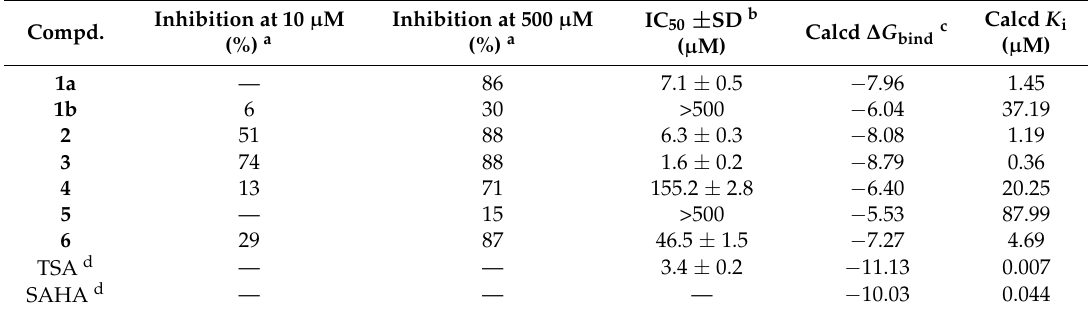
Table 1. HDAC inhibitory activity of compounds 1 – 6 , Trichostatin A (TSA) and suberoylanilide hydroxamic acid (SAHA) and calculated ∆ G bind and the corresponding K i .